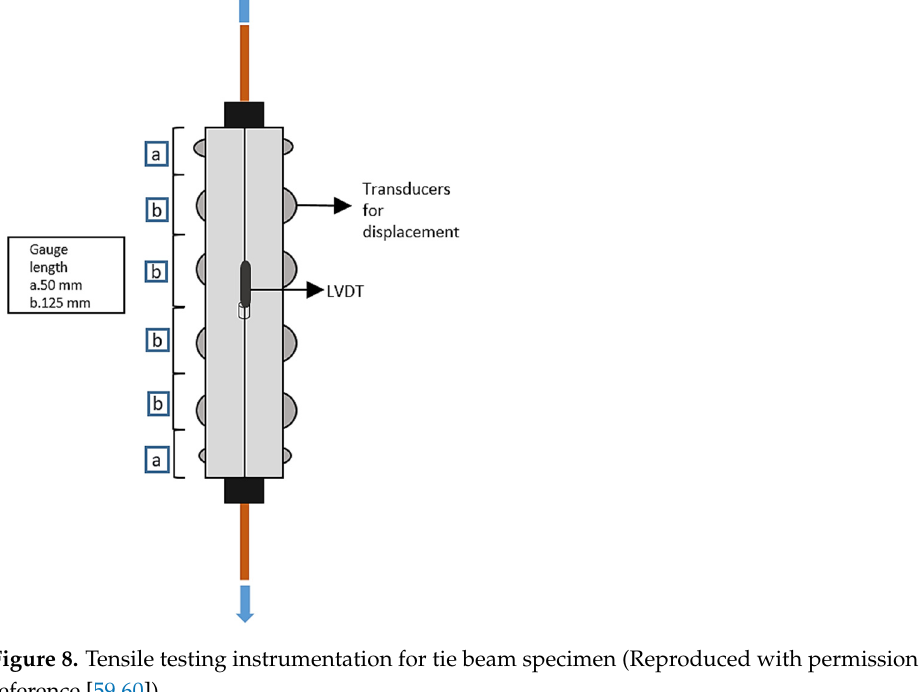
Figure 8. Tensile testing instrumentation for tie beam specimen (Reproduced with permission from reference [59,60]).